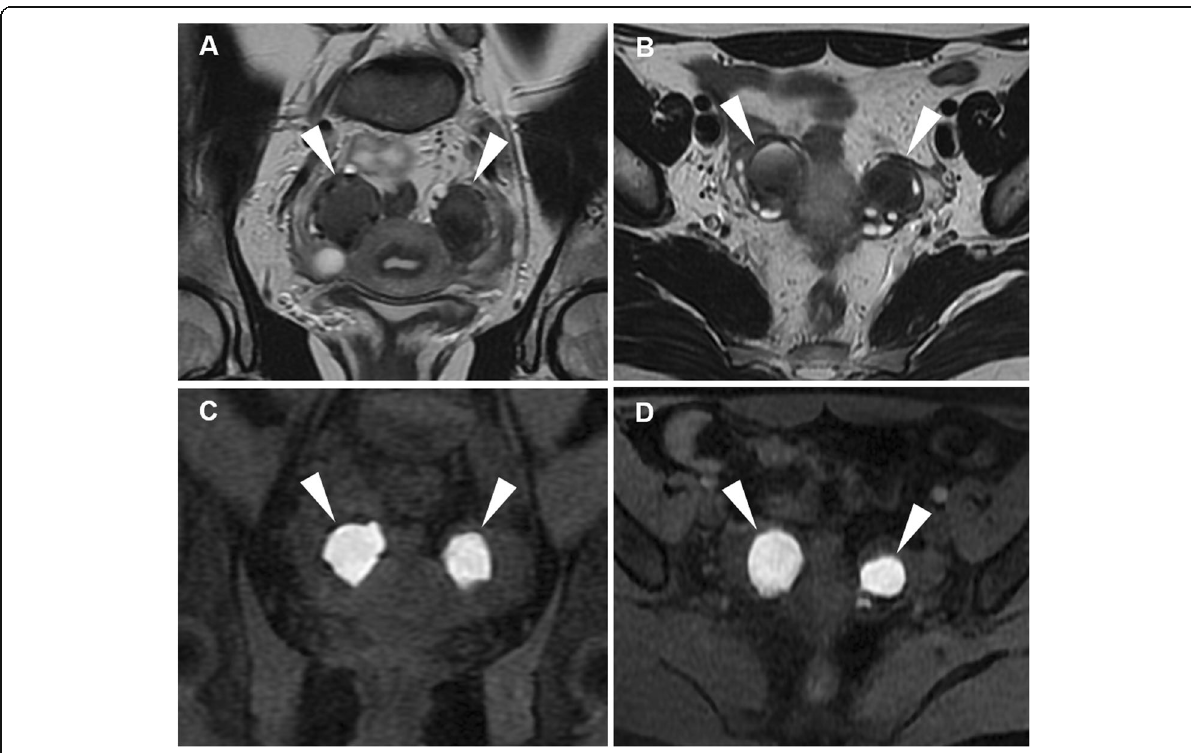
Fig. 11 MRI of bilateral endometriomas in a 31-year-old woman suffering from lumbar and pelvic pain. Oblique-axial ( a ) and oblique-coronal ( b ) T2-weighted images show bilateral endometriomas (arrowheads) with variable grade of low signal intensity until complete signal loss ( ‘ shading sign ’ ). On oblique-axial ( c ) and oblique-coronal ( d ) precontrast fat-suppressed T1-weighted images, the cysts display homogeneous high signal